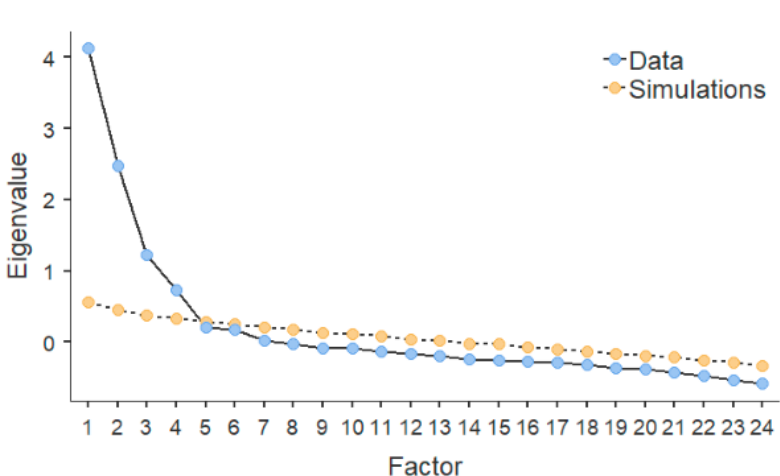
Figure 1. Screeplot of the EFA and parallel